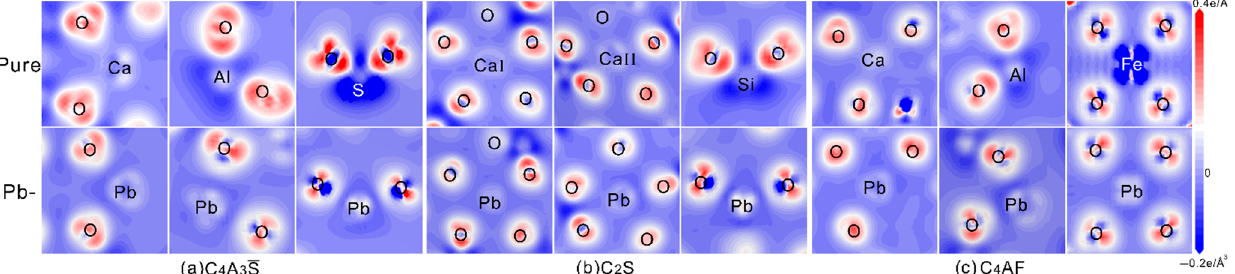
Figure 5. The partial density of states (PDOS) of pure and Pb-doped SAC clinker Phases: ( a ) C 4 A 3 S(cid:3364) , ( b ) C 2 S, and ( c ) C 4 AF. The Fermi energy was set to zero eV.